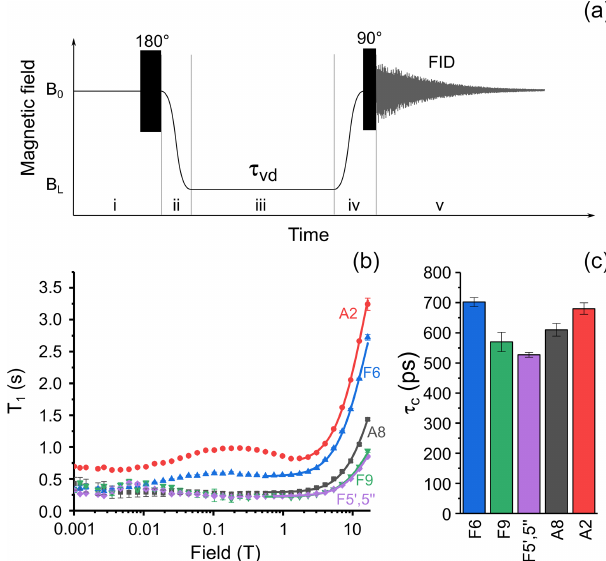
Figure 3. (a) Experimental protocol for measuring nuclear spin re- laxation dispersion. In step (i), spins relax to thermal equilibrium at high field B 0 , then a 180 ◦ RF pulse is applied for inversion of magnetization. In step (ii), the sample is transferred to the field B L , where it is kept for an incremented delay τ vd during step (iii). In step (iv), the sample is transferred back to high field B 0 and a 90 ◦ RF pulse is applied. In step (v), the nuclear spin free-induction de- cay is acquired, and the NMR spectrum is obtained after complex Fourier transform. (b) Relaxation dispersion data for six selected protons of FAD: A8 – black squares, A2 – red circles, F6 – blue up-pointing triangles, F5 (cid:48) ,5 (cid:48)(cid:48) – magenta diamonds, and F9 – green down-pointing triangles. Lines show best fit of high-field part of relaxation dispersion curves by Eq. (1). (c) Correlation times ob- tained from fitting the high-field part of relaxation dispersion data for protons A8; A2; F5 (cid:48) ,5 (cid:48)(cid:48) ; F6; and